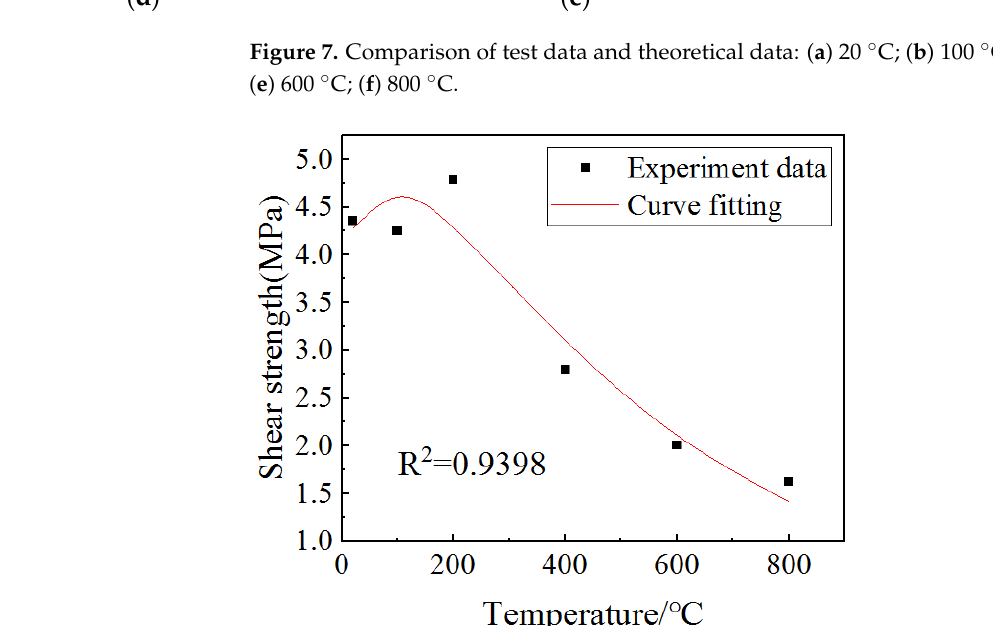
Figure 8. Fitting curve of the relationship between shear strength and heated temperature.